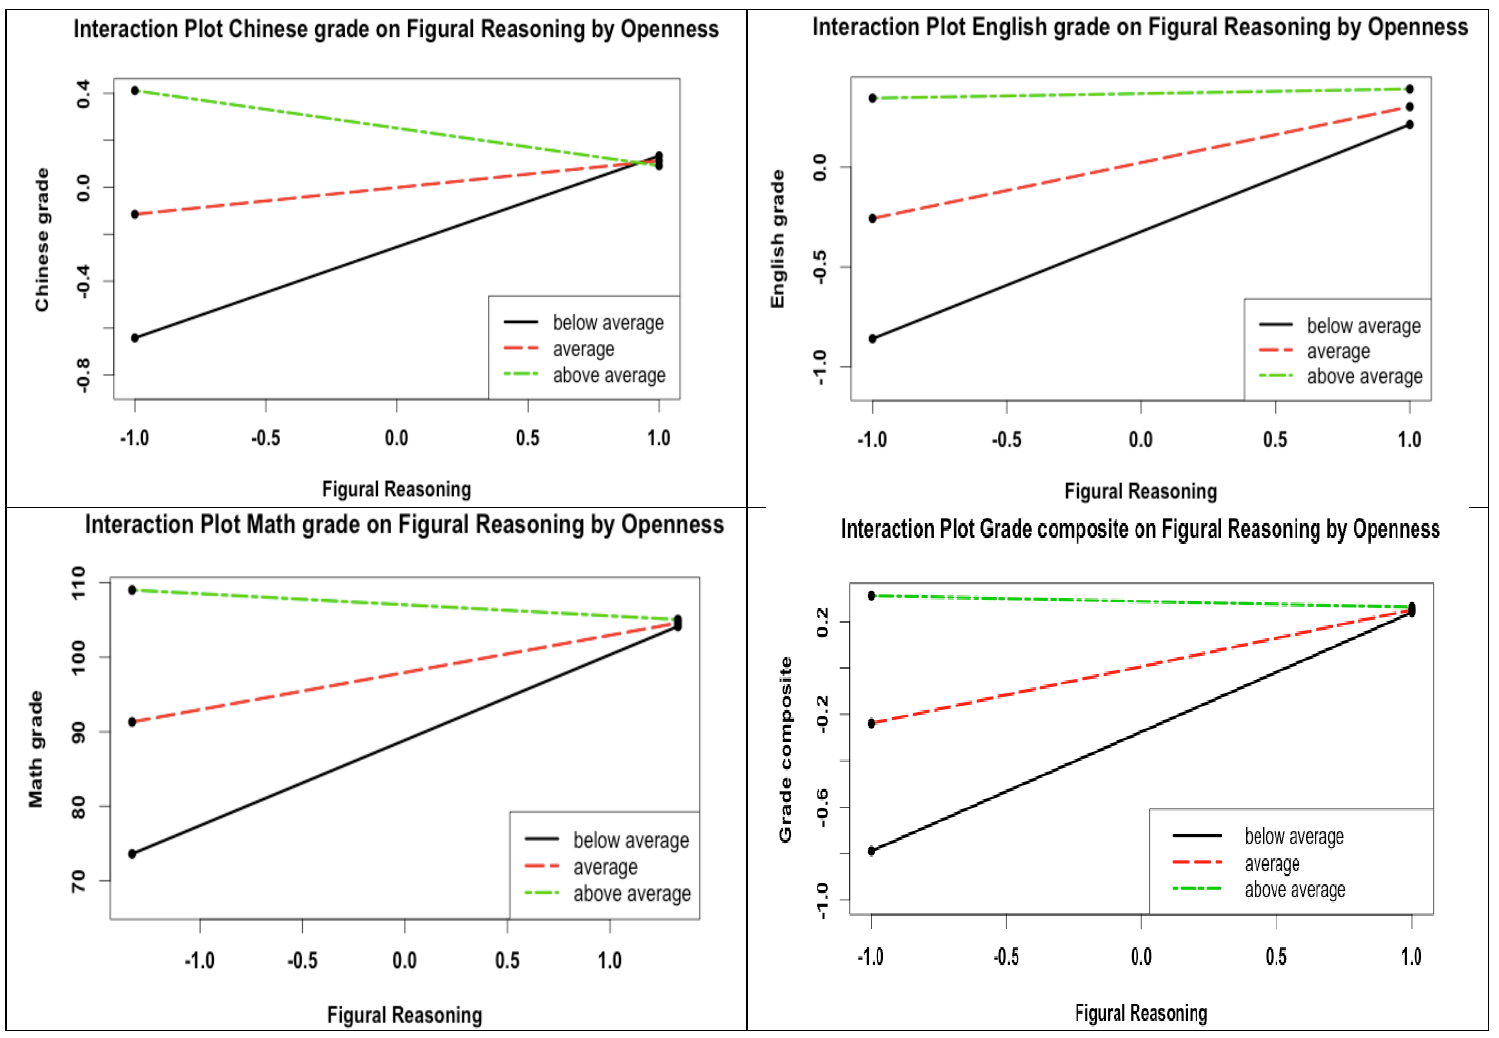
Figure 1. Interaction plots for the moderating effect of Openness on the correlation between figural reasoning and school grades in Chinese, Math, English, and a grade